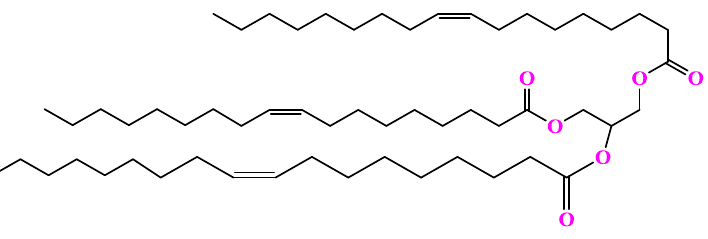
Figure 3. The structure of triolein.